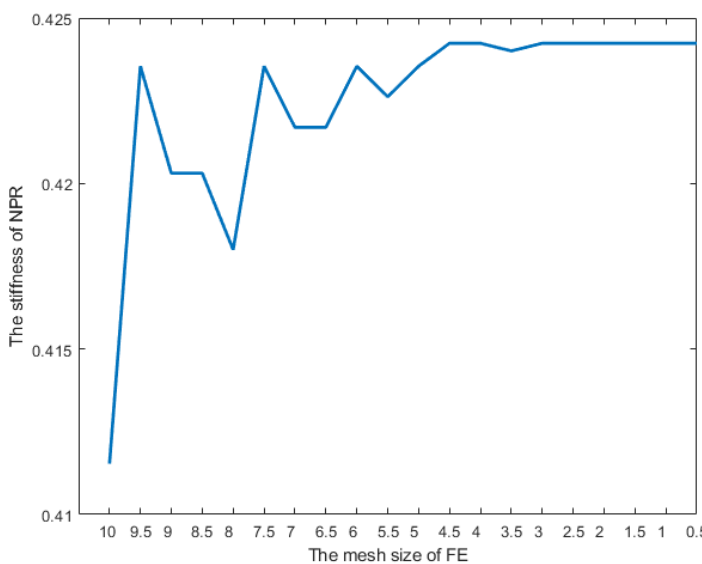
Figure 9. The convergence of the mesh size of a 2D double-V NPR microstructure.